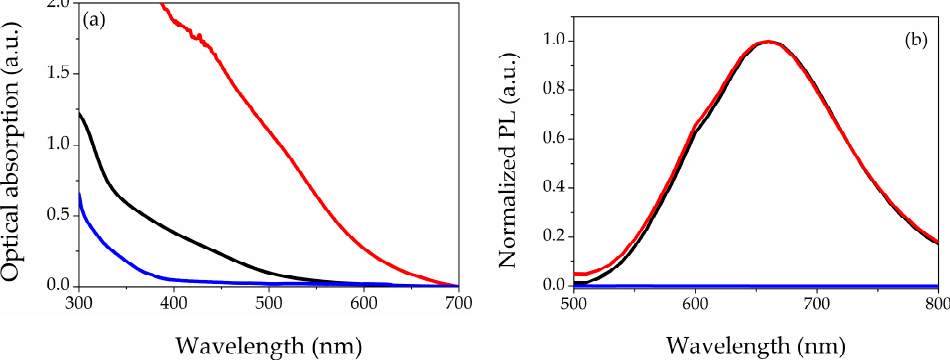
Figure 1. Optical characterizations: ( a ) UV-Vis optical absorption of AgNCs-PMAA colloidal solution (black curve), dried hydrogels with (red line) and without (blue curve) AgNCs-PMAA; ( b ) normalized photoemission spectra excited at λ = 430 nm of AgNCs-PMAA colloidal solution (black curve), dried hydrogels with (red line) and without (blue curve) AgNCs-PMAA.